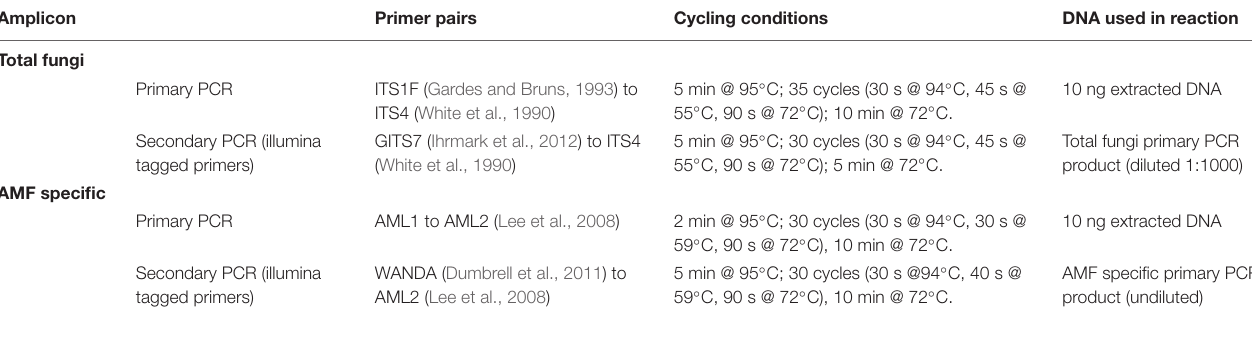
TABLE 2 | Primer sets and PCR conditions used in nested PCRs for “total fungi” and “AMF specific” amplicon sequencing. Amplicon Primer pairs Cycling conditions DNA used in